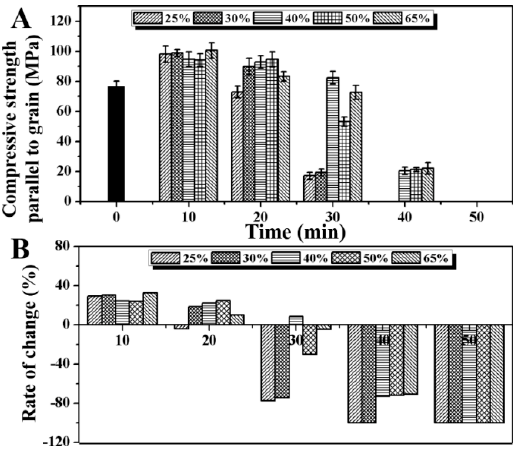
Figure 5. ( A ) Results of compressive strength along grain of bamboo before and after saturated steam heat treatment under different moisture content conditions, and ( B ) the change rate with the prolongation in heat treatment time.